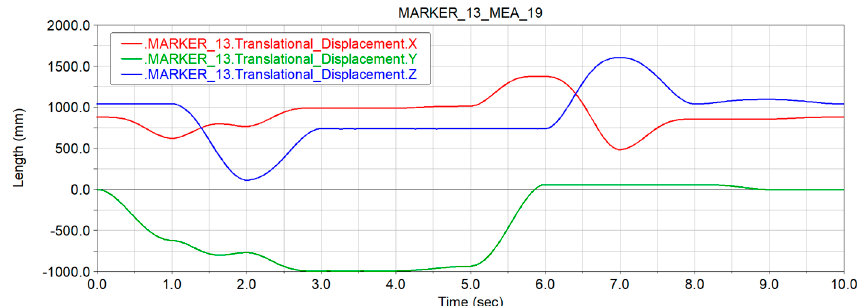
Figure 11. Simulation displacement curve of robot in each direction.